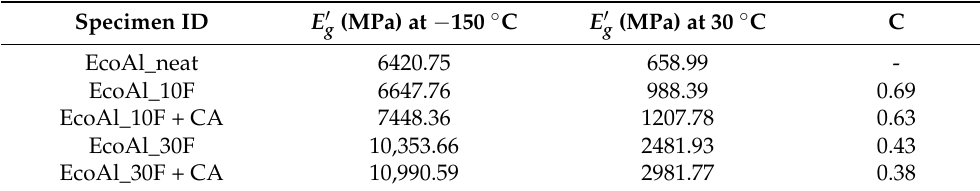
Figure 9. ( a ) Storage modulus and ( b ) tan δ curves as a function of temperature for all EcoAllene-based composites. Table 5. Storage modulus and fibre effectiveness coefficients (C) of EcoAllene-based composites calculated according to Equation (1).